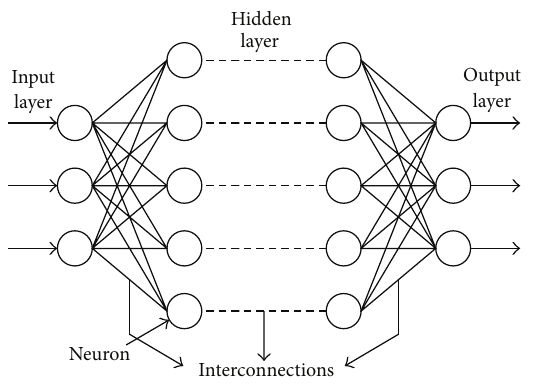
Figure 3: Network